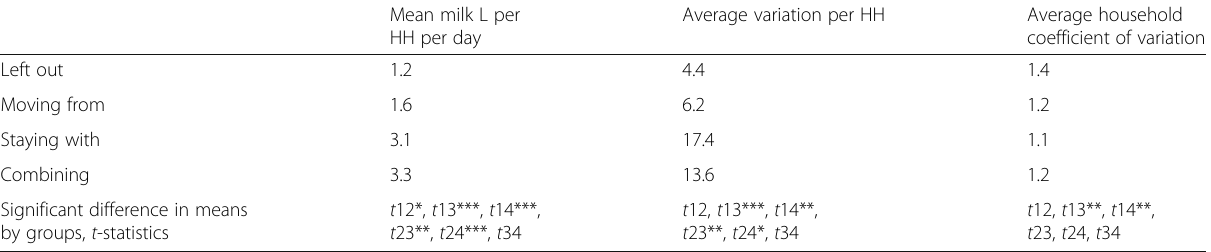
Table 3 Average household daily milk production, variation over periods in the average, and corresponding coefficient of variation in milk production by household